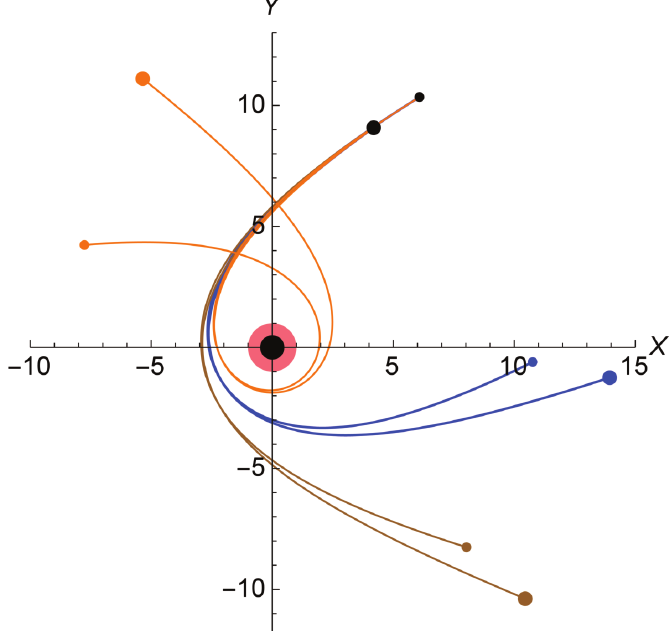
Figure 4. Illustrative simulation of the process of tidal destruction of a stellar body by a fast-rotating massive black hole: two fragments of the initially cohesive stellar body—depicted as the black dot near dimensionless coordinates (+6; +10)—follow different, bound or unbound, trajectories depending on the initial parameters of the system